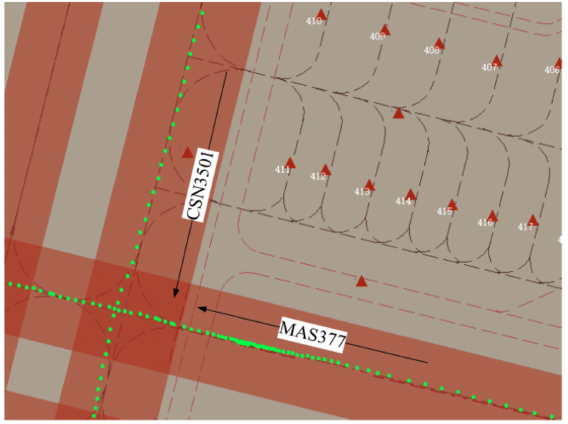
Figure 13. Actual Taxiing Trajectory in Case